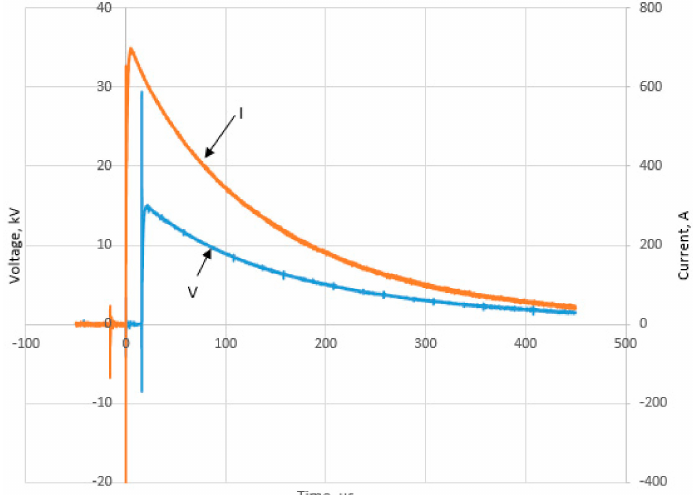
Figure 7. Voltage and current traces of positive polarity for electrodes installed at site 3 at a charging voltage of 30 kV.